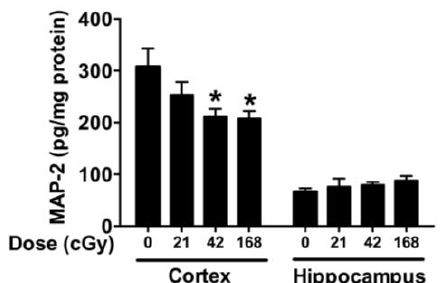
Figure 4. MAP-2 levels in the cortex and hippocampus. There was a radiation × brain region interaction ( F (3,64) = 4.577, p = 0.0058). When the cortex and hippocampus were analyzed separately, in the cortex, there was an effect of irradiation ( F (3,32) = 3.827, p = 0.0189, ANOVA) with mice irradiated with 42 or 168 cGy showing lower cortical level of MAP-2 than sham-irradiated mice. In the hippocampus, there was an effect of irradiation ( F (3,32) = 4.395, p = 0.01, Brown–Forsythe test), but none of the post hoc tests reached significance. n = 9 mice/radiation condition/brain region. * p < 0.05.